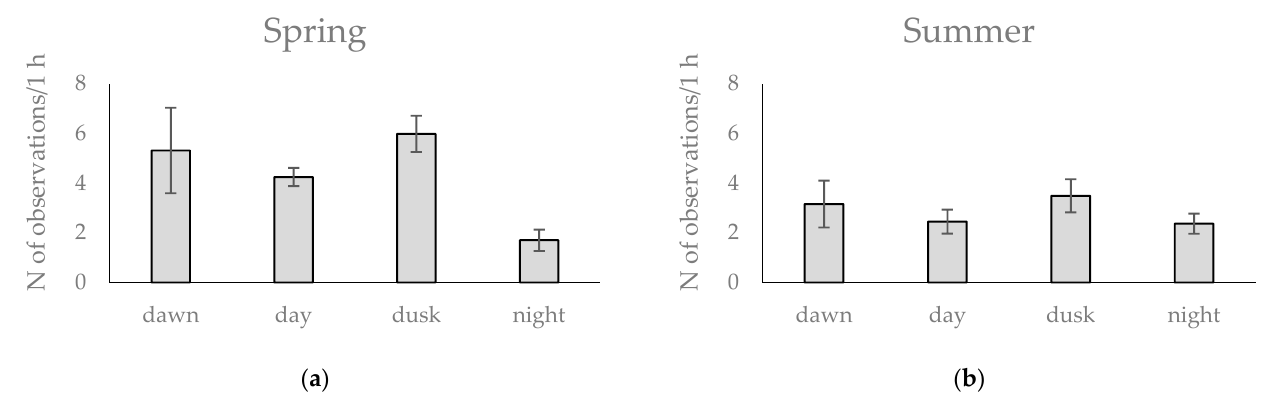
Figure 4. Mean (+SE) number of roe deer camera-trap observations per one hour during different parts of the day during ( a ) spring (March–May) and ( b ) summer (June–August) in urban forests of Warsaw in years 2019–2020.